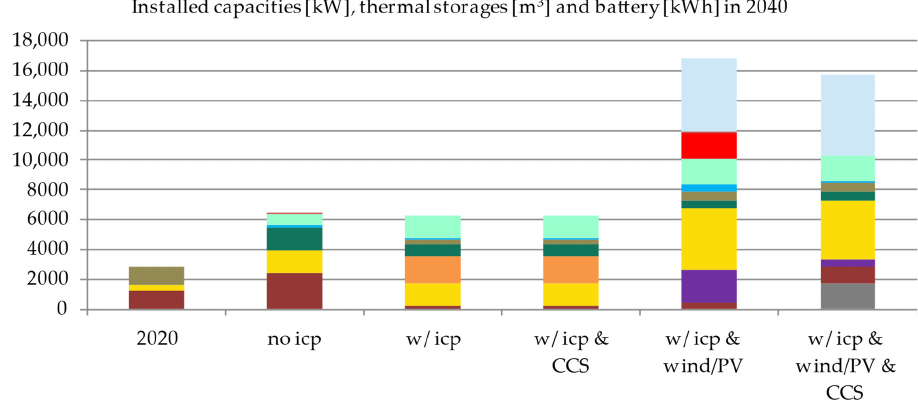
Figure 3. Installed capacities for the German scenarios in 2040.